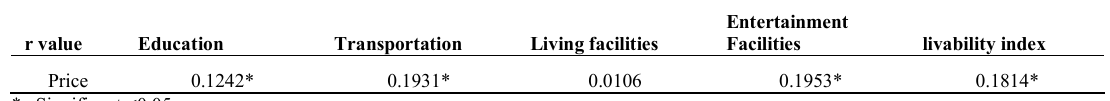
Table 2. Results of Correlation